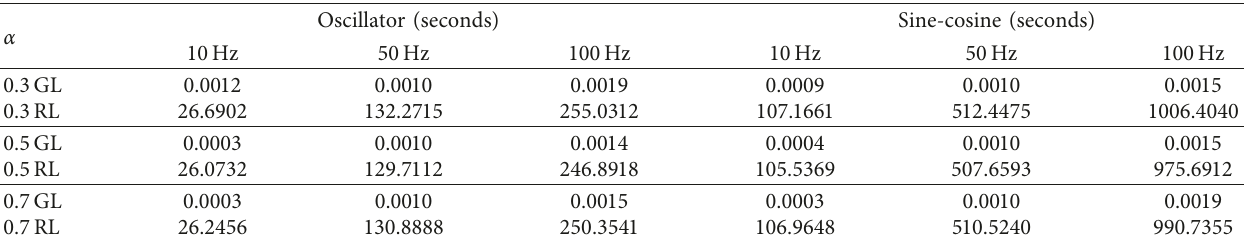
Table 2: Execution times, in seconds, for GL and RL algorithms using α � 0 . 3 , 0 . 5 , and 0 . 7 for both oscillator and sine-cosine signals at different samples